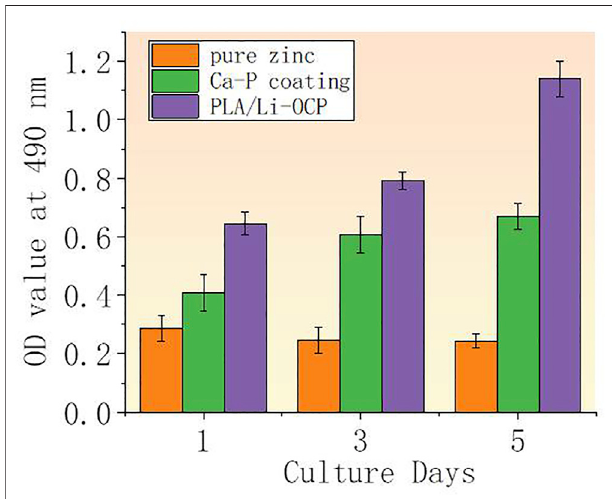
Figure 8 , alive cells failed to adhere to the pure zinc surface, showing lytic morphology, a characteristic of dead cells. This case was slightly changed in the Ca-P-coated samples. In contrast, these conditions were changed by the presence of PLA/Li-OCP coatings. It can be seen that the cells attached to the PLA/Li-OCP coatings show a